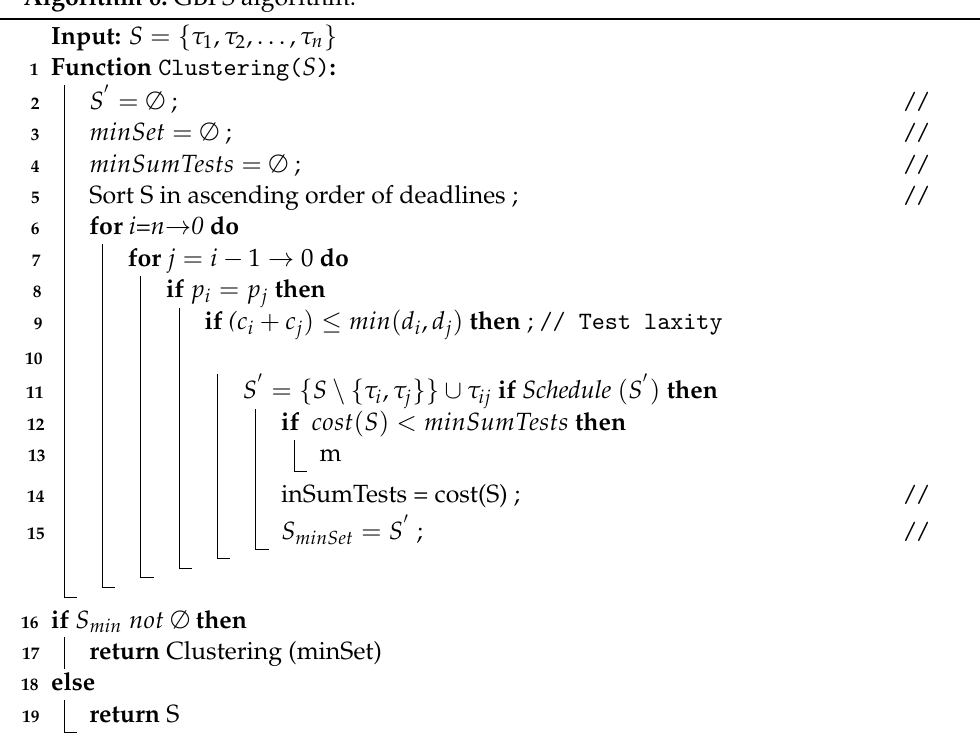
Algorithm 6: GBFS